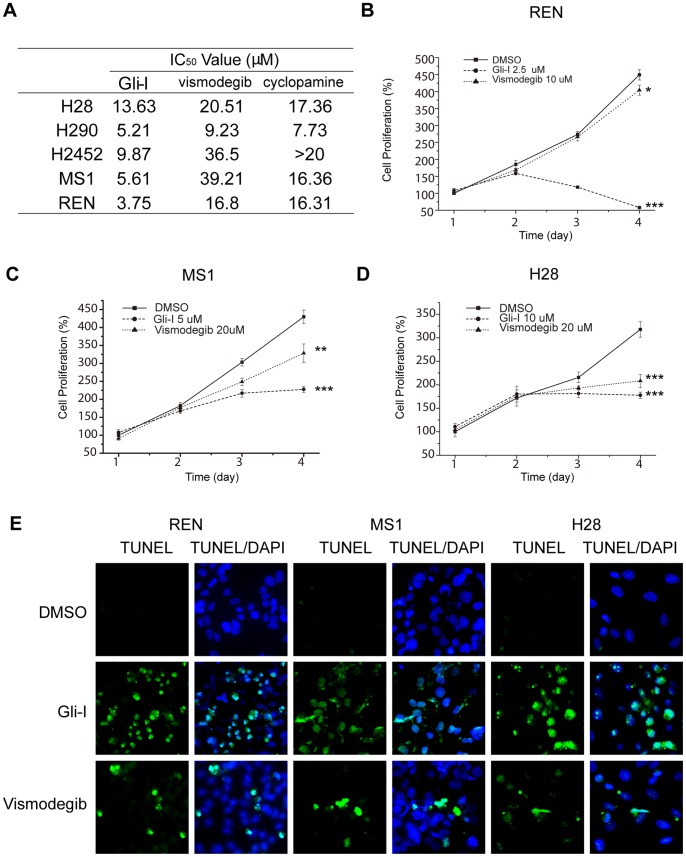
The Gli Inhibitor is More Potent than the Smo Inhibitors to Inhibit MPM Cell Proliferation. A, IC50 comparison of Gli-I and the Smo inhibitors. Cells were treated with corresponding compounds at 7 different concentrations for 72 hours to obtain a dose-respond curve in order to determine IC50 values. B–D, Gli-I achieved a better suppression of cell proliferation than the Smo inhibitor in three MPM cell lines. MTS assay was used to measure cell proliferation at 72 hours upon drug treatment. Two-sided student’s t-test was performed between DMSO and drug treated cells. A p value <0.05 was indicated as *, <0.01 as **, and <0.001 as ***. E, Apoptosis in Gli-I and vismodegib treated cells. TUNEL assays were performed at 40 hours after drug treatment, with TUNEL in green and DAPI in blue.